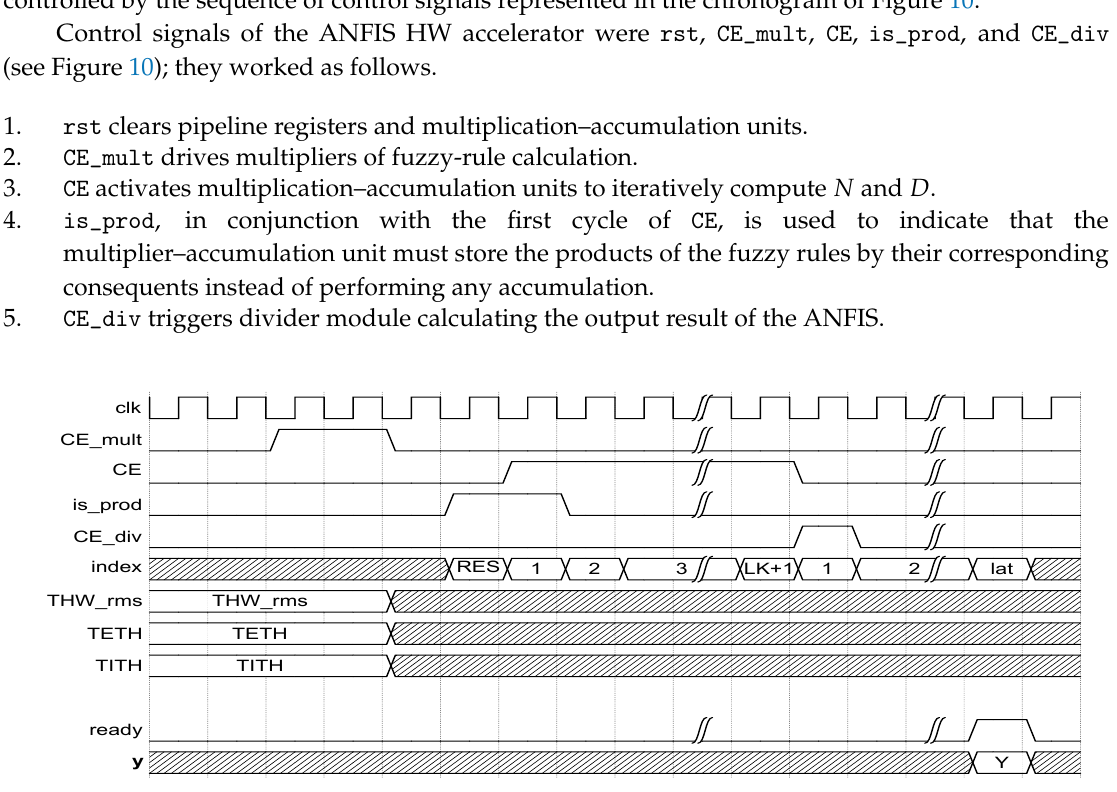
Figure 10. Chronogram of control-signal sequence of the ANFIS